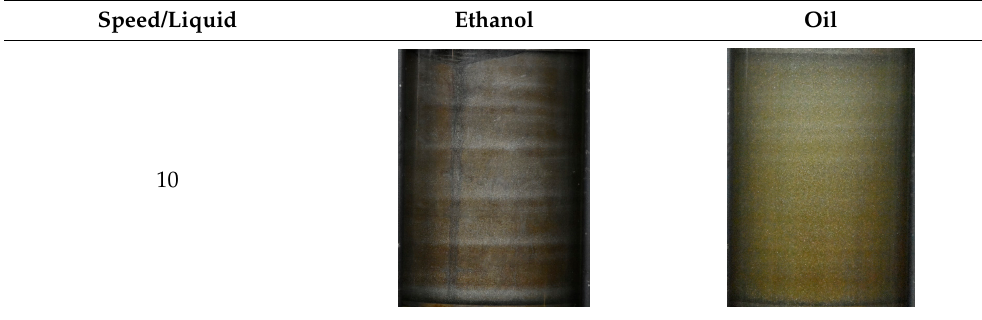
Table 3. Flow visualization for a 10-rpm speed.